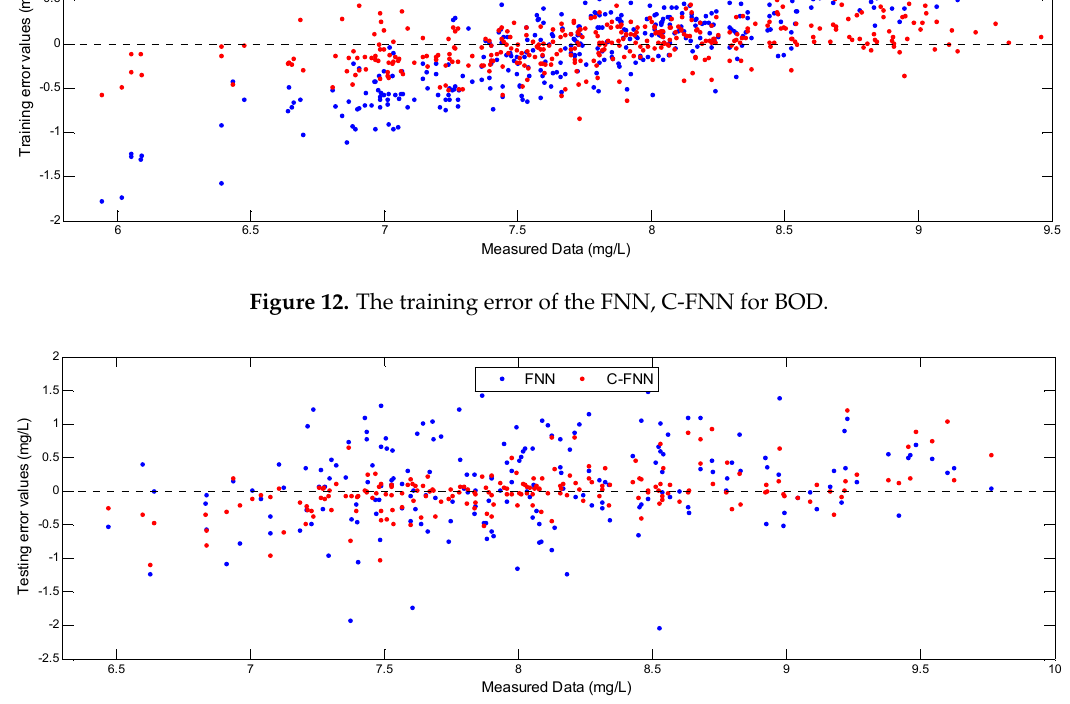
Figure 13. The testing error of the FNN, C ‐ FNN for BOD.